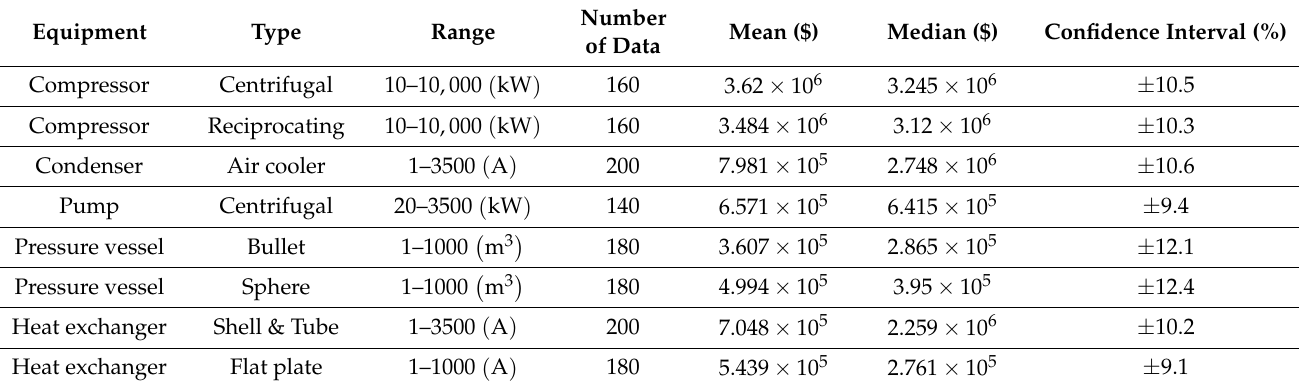
Table 1. The statistical parameters of